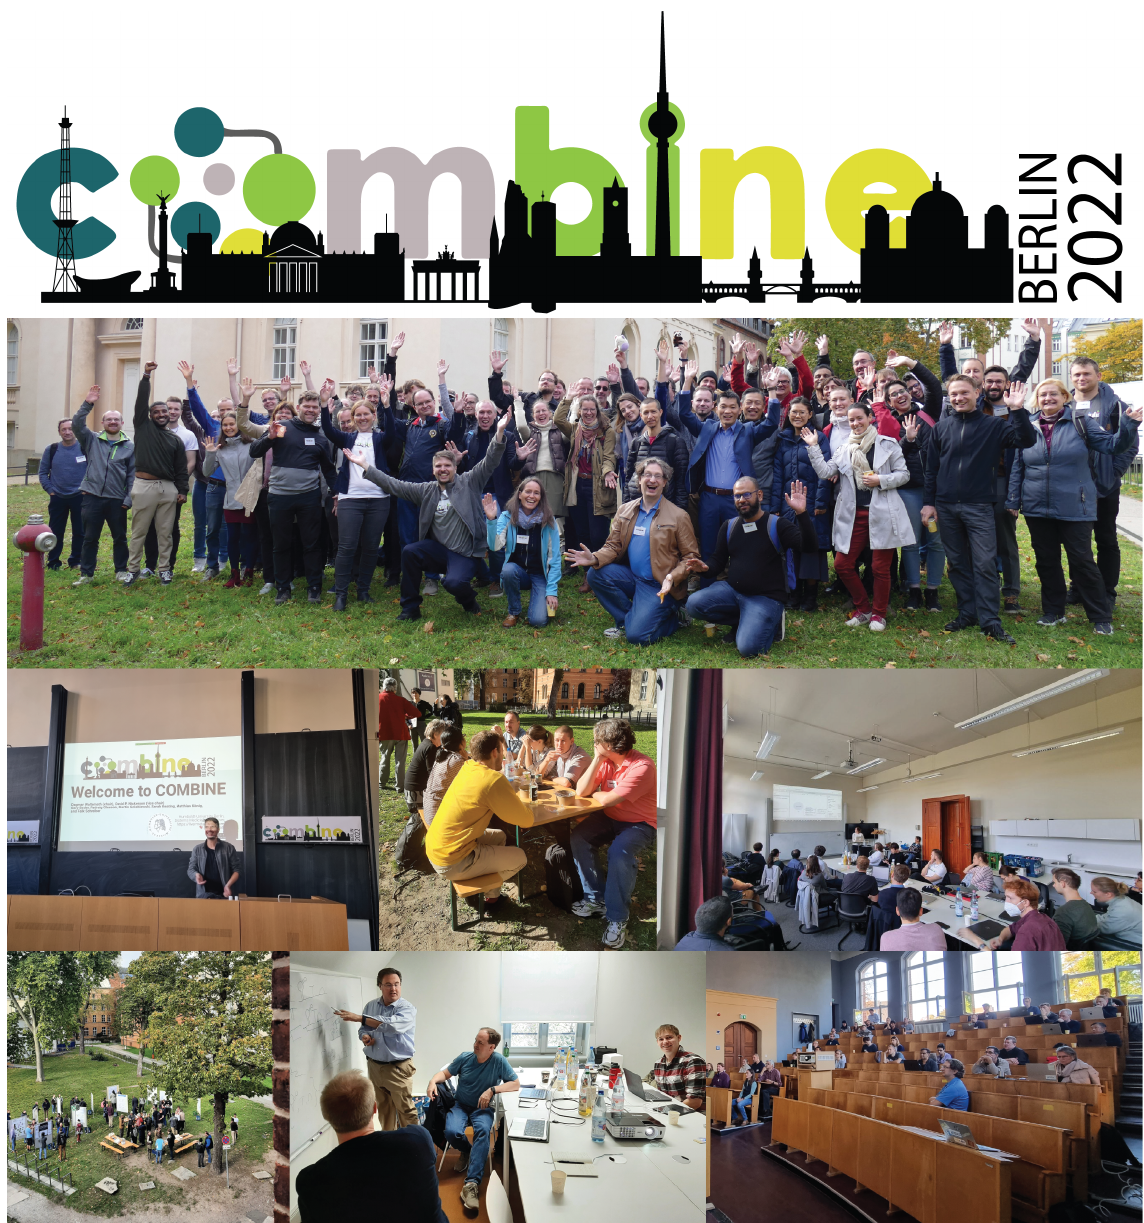
Figure 2: COMBINE meeting 2022 at the Humboldt-University